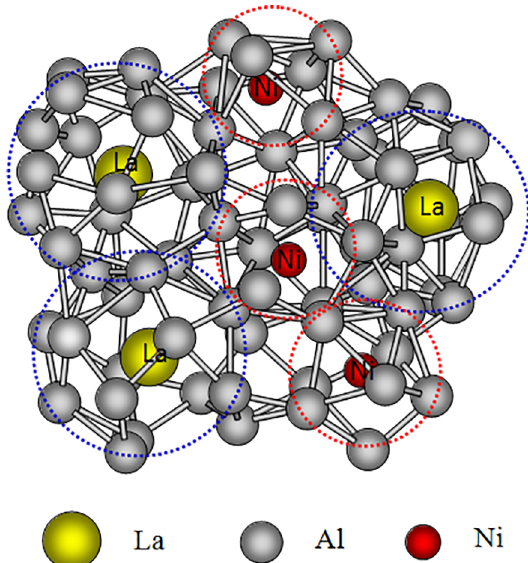
Figure 5. Quasi-equivalent clusters in Al-based metallic glasses 134 .